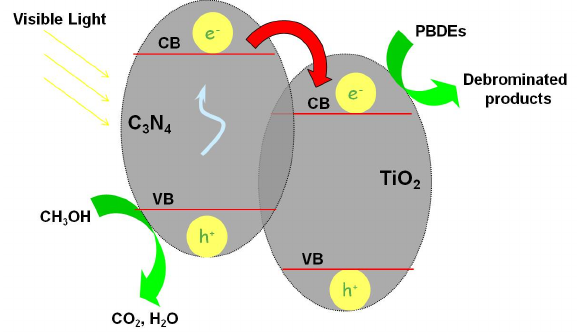
Figure 9. Proposed mechanism of the degradation of PBDEs with g ‐ C 3 N 4 ‐ TiO 2 in CH 3 OH solution under visible irradiation. CB: conduction band; VB: valence band.